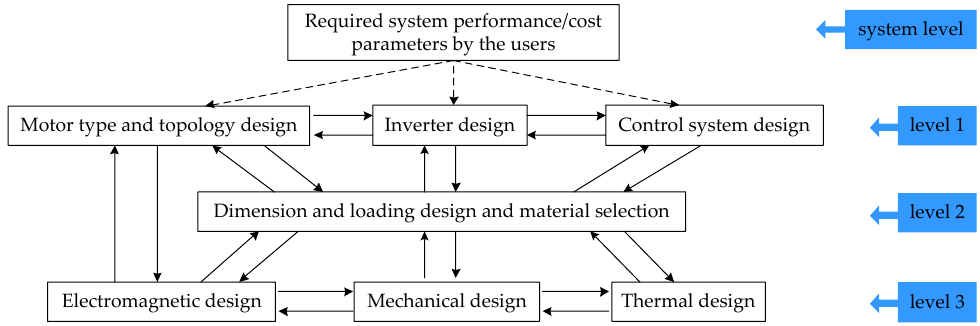
Figure 11. Framework of system-level design optimization method for electrical drive systems. Energies 2017 , 10 , 1962